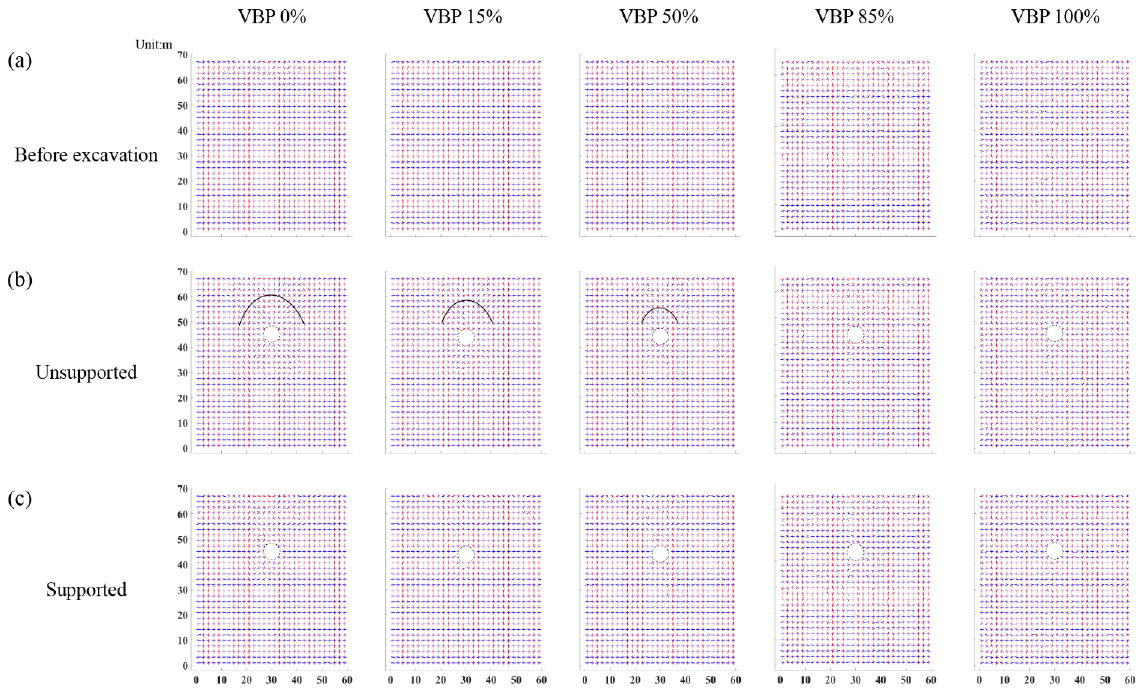
Figure 14. The directions of the principal stresses in the ground of ( a ) initial state before excavation, ( b ) unsupported tunnel excavation and ( c ) supported tunnel excavation. The red and blue segments indicate the maximum and minimum principal stresses, respectively. The black curve indicates the arching formed above the tunnel excavation.